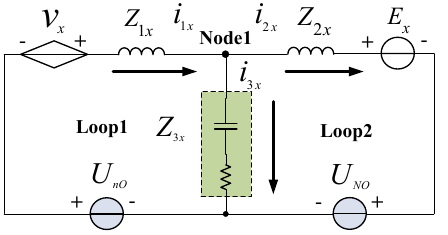
Figure 4. Equivalent circuit in each phase (x = A, B, C,